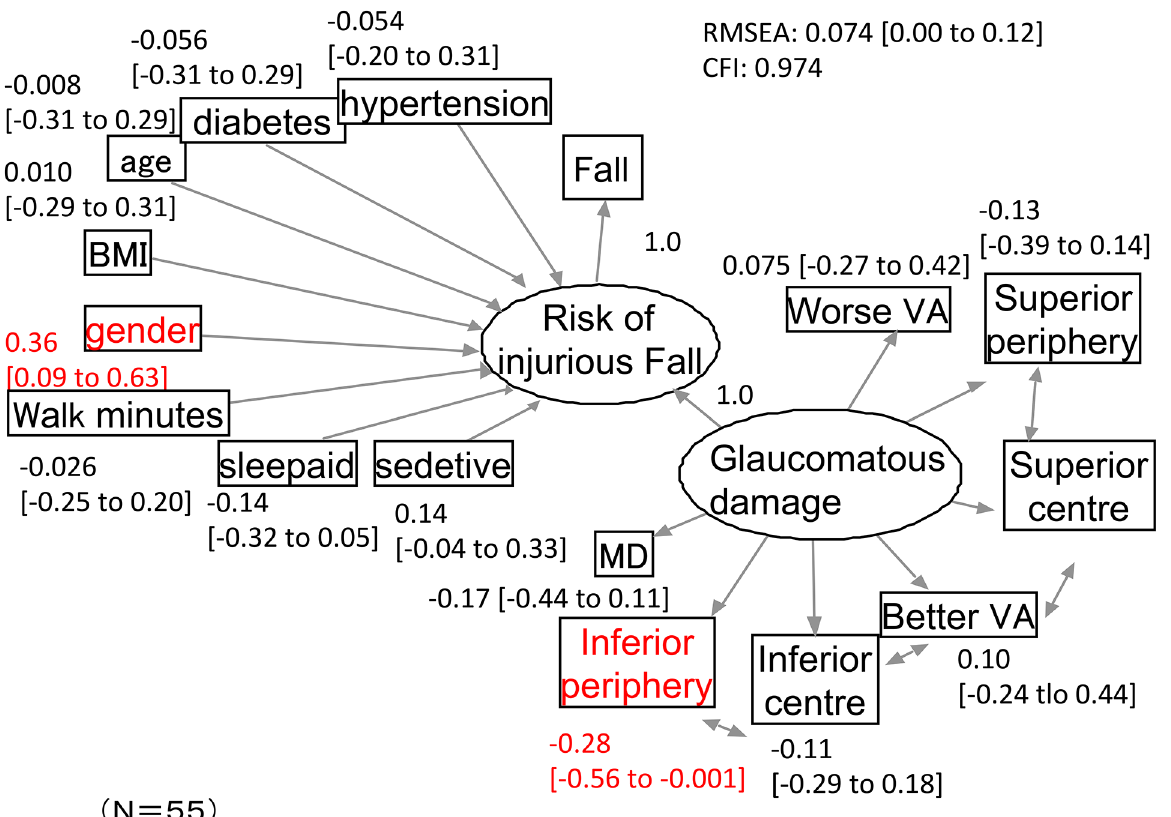
Fig 3. The structural equation modeling path diagram for the analysis of risk of injurious falling. The model obtained an RMSEA of 0.074 and a CFI of 0.97. Among the 95% confidence intervals (CIs) of regression coefficients, only those from gender and average TD values in the lower peripheral VF did not cross 0 (written in red). Variables in circles represent latent variables ( ‘ Glaucomatous Damage ’ and ‘ Risk of injurious falling ’ ). Parentheses represent 95% CIs. BMI: body-mass index, gender: male: 0, female: 1, sleep aid: usage of sleep aid, sedative: usage of sedative. Superior peripheral, superior central, inferior central and inferior peripheral: means of the total deviation values in the superior peripheral, superior central, inferior central and inferior peripheral areas, respectively. MD: mean of the total deviation values in whole field. VA: visual acuity.